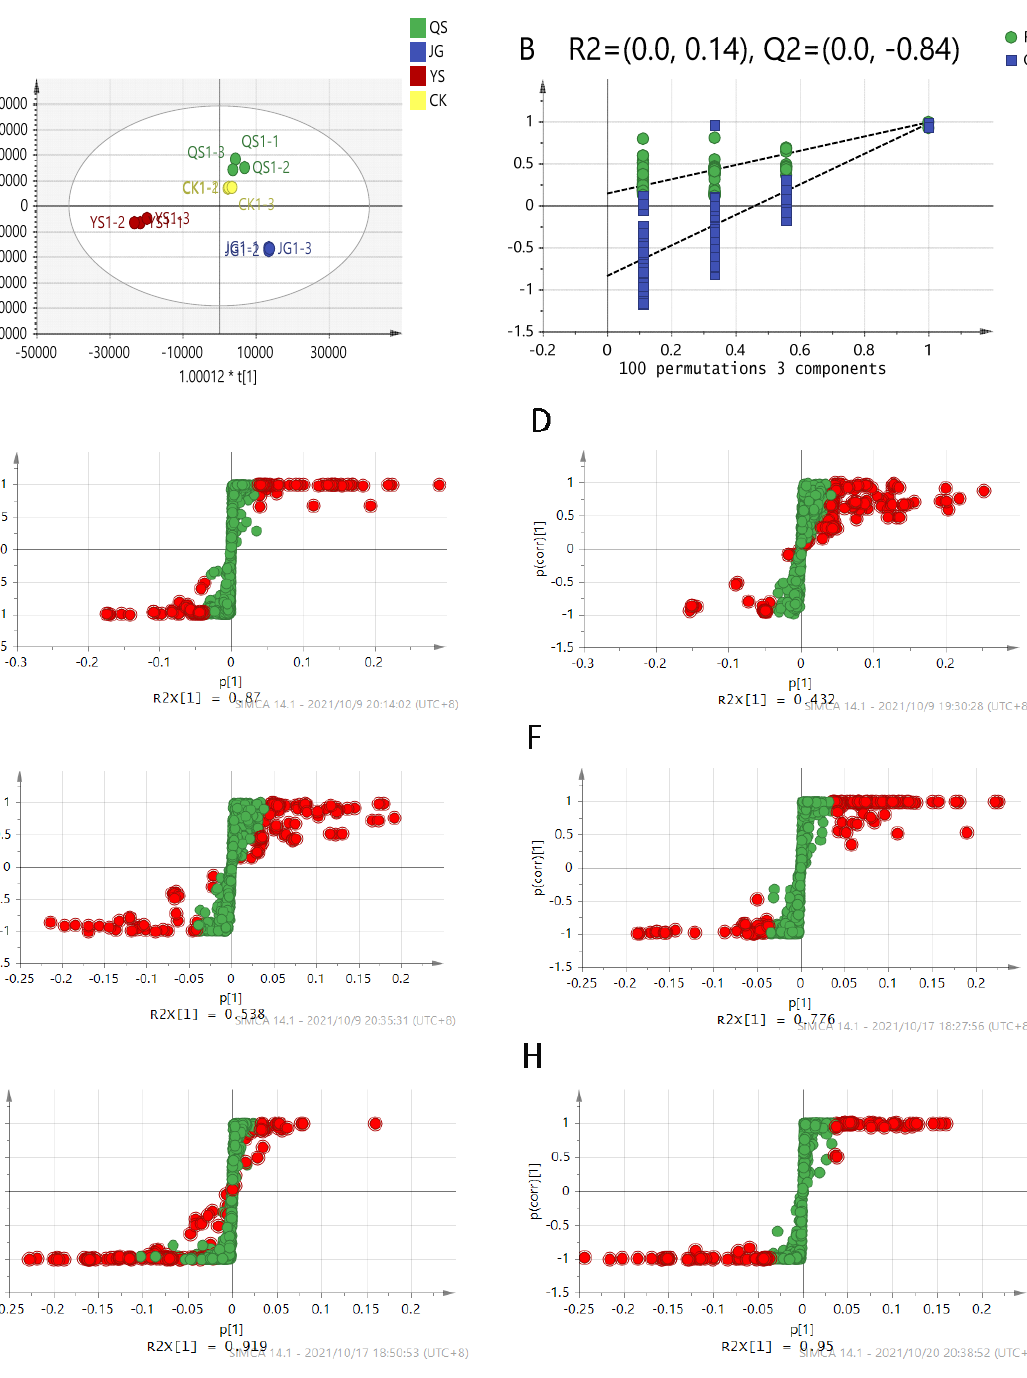
Figure 3. ( A ) Score scatter plot of the OPLS-DA model for all Laoxianghuang samples (R2X = 0.938, R2Y = 0.993, Q2 = 0.985). ( B ) Permutation test plot with 100 cycles. R 2 represents the percentage of model matrix information; Q 2 represents the predictive power of the original model. Loading S-